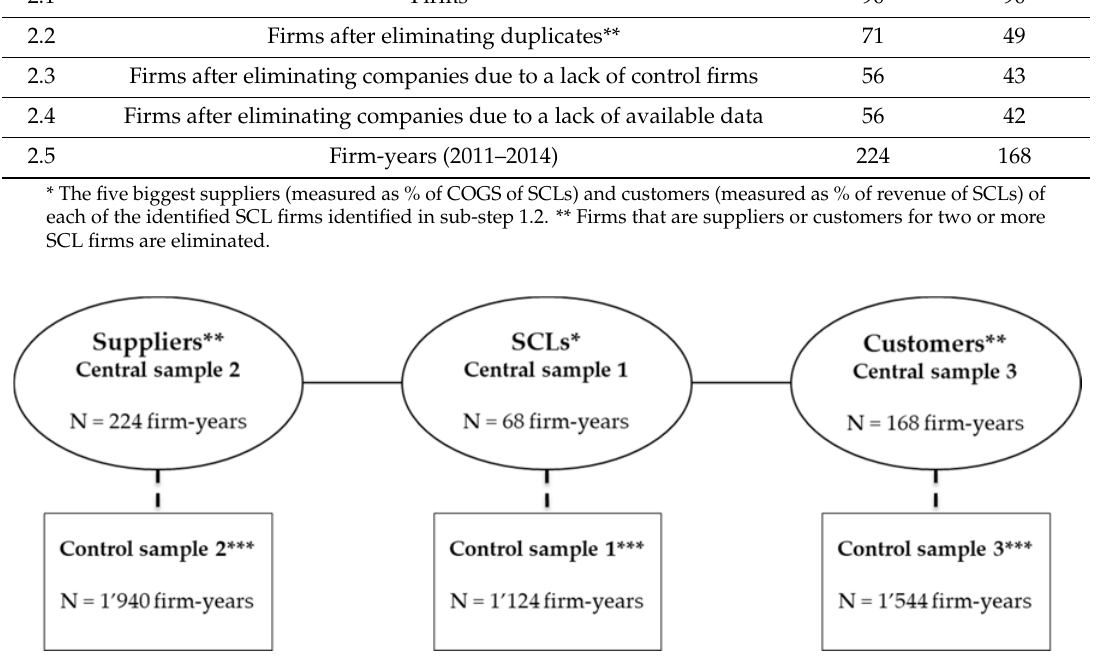
Figure 2. Number of firm-years in the samples and sources of data. * Sample selection source: Gartner Supply Chain Top 25. ** Sample selection source: Bloomberg. *** Sample selection source: